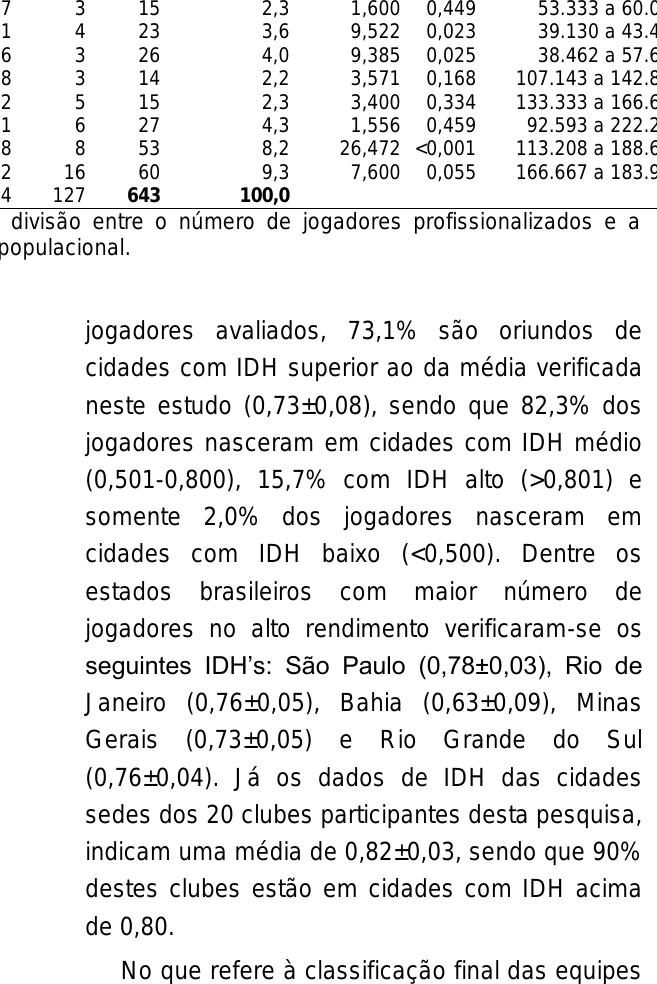
*As chances de ascensão foram calculadas por uma divisão entre o número de jogadores profissionalizados e a população mínima e máxima contida em cada intervalo